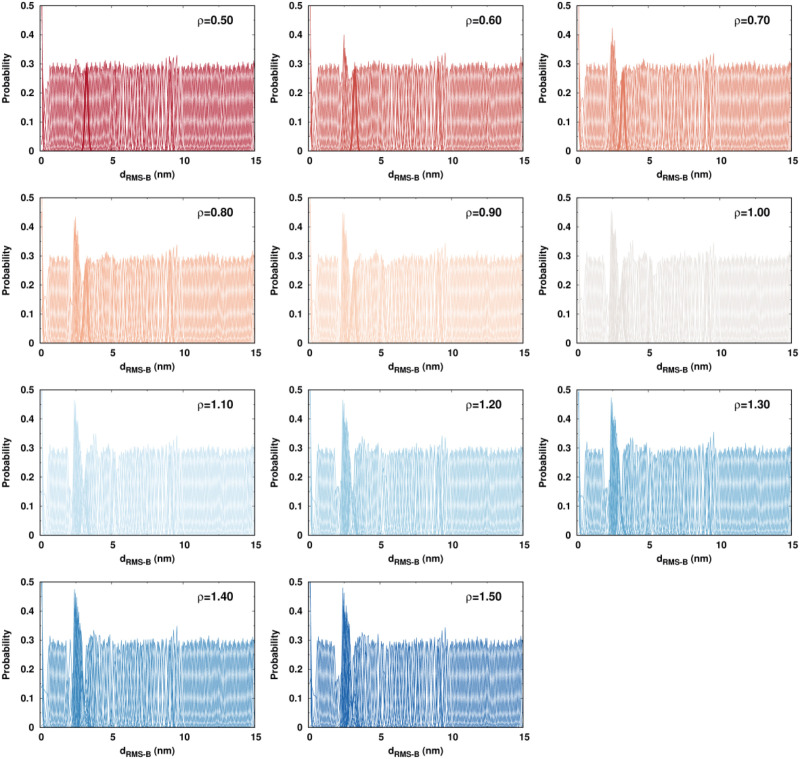
Biased DPO4–DNA binding simulations performed by the umbrella sampling.The overall overlaps of the probability distribution on dRMS between neighboring replicas are apparent, indicating a sufficient sampling.